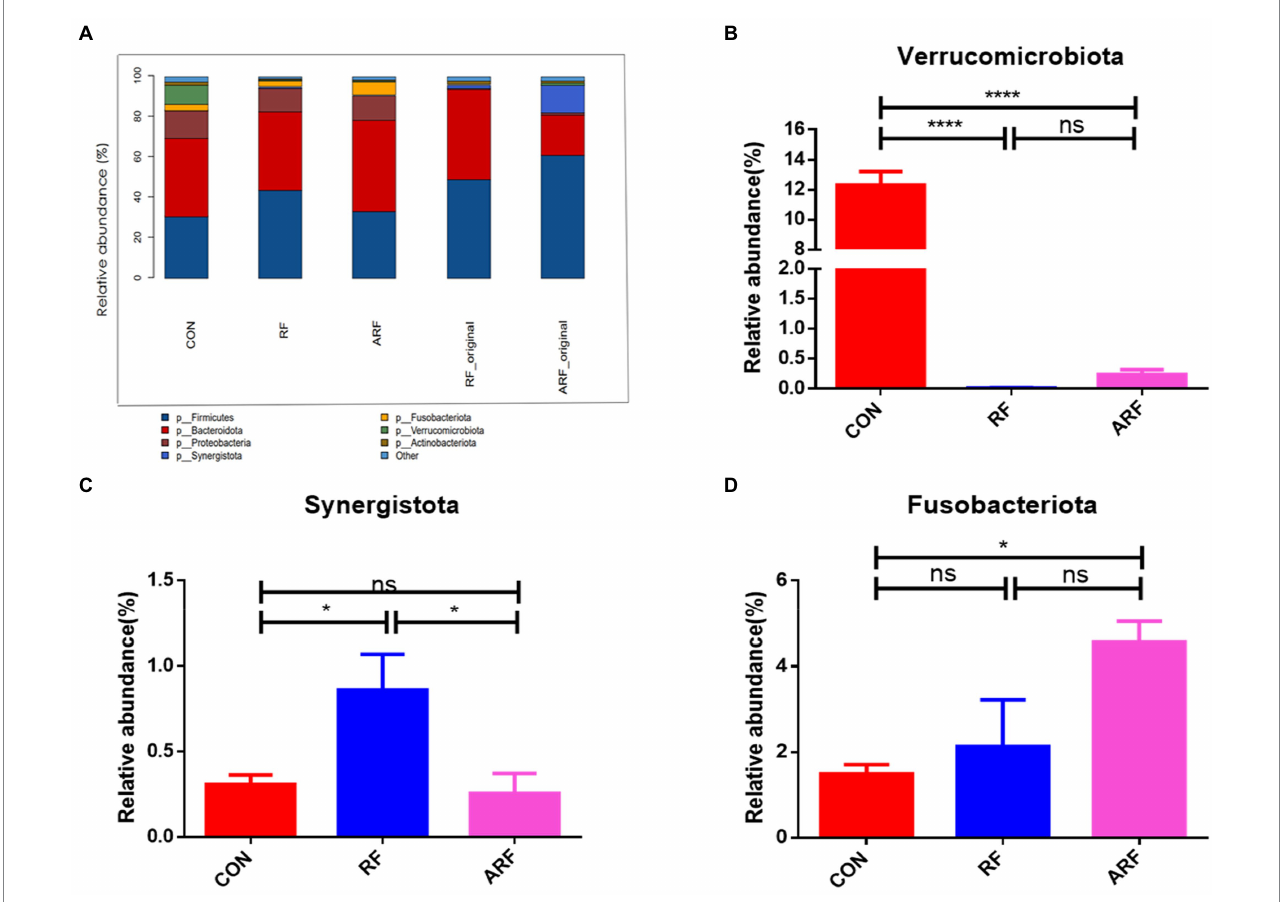
(D) Ratio of Fusobacteriota in the three groups. n = 8, * p < 0.05, ** p < 0.01, *** p < 0.001, **** p < 0.0001, ns indicates no